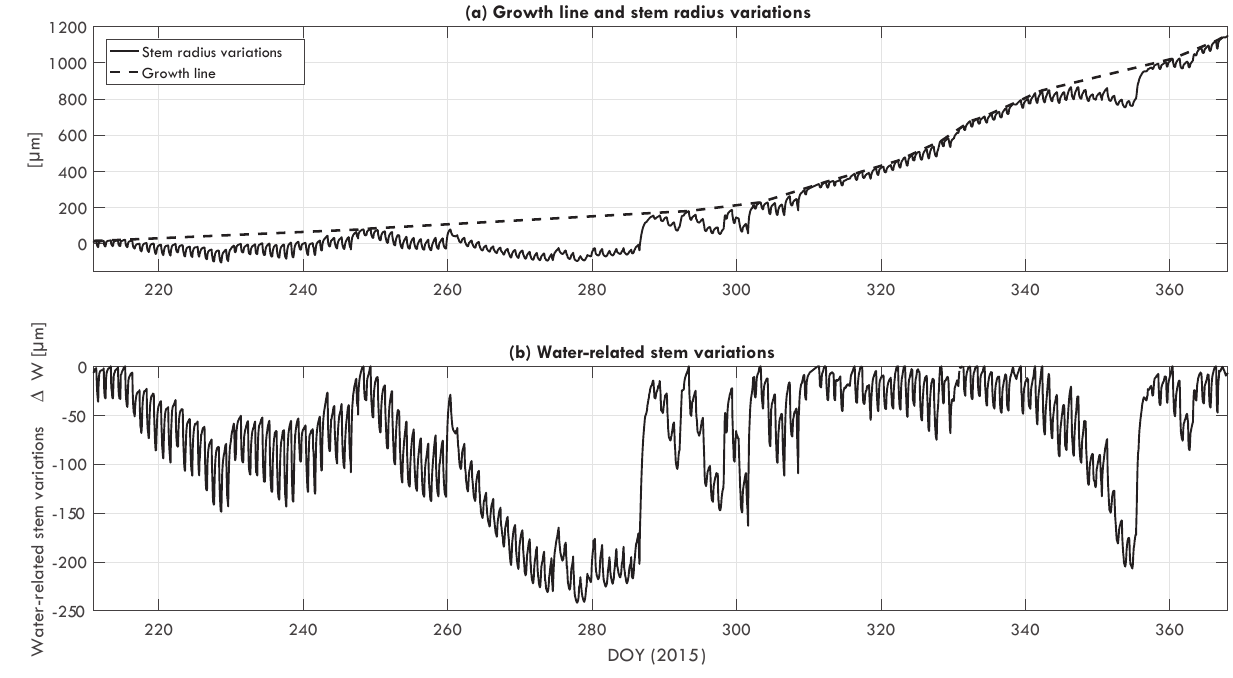
Figure 1. (a) Growth line and steam radius variation for Goupia glabra tree 1, and (b) the calculated water-related stem variation (cid:49)W [µm], from August 2015 to December